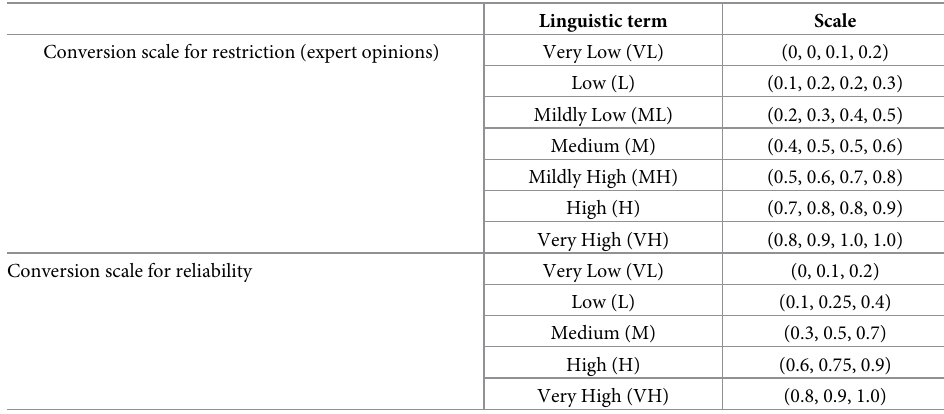
Table 4. Corresponding Z-applied